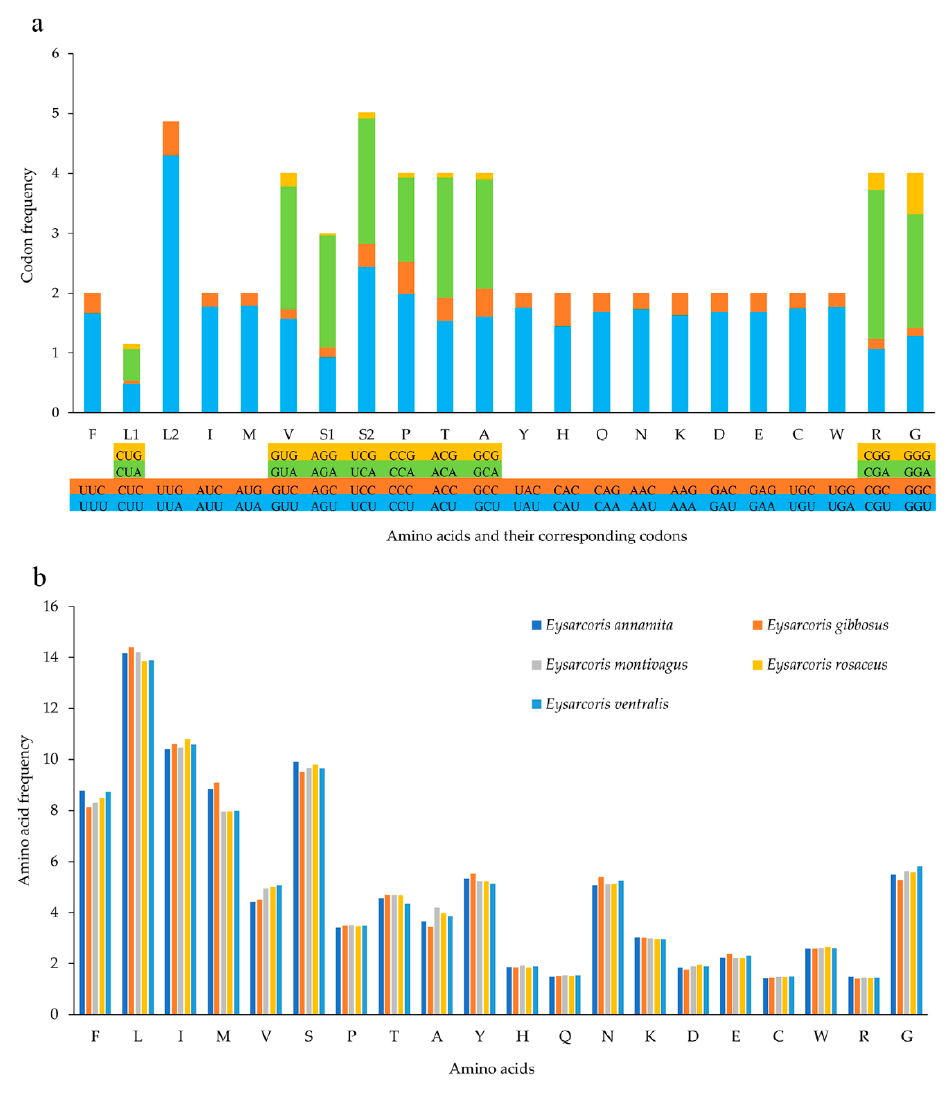
Figure 2. The frequencies of utilized codons by amino acid ( a ) and the frequency of amino acid occurrence ( b ) in the five newly sequenced mitochondrial genomes. The stop codon is not given. The values of Ka, Ks and Ka/Ks were calculated for each PCG to investigate the evolutionary patterns among mitochondrial PCGs in Pentatominae (Figure 3). The Ka/Ks ratio for all 13 PCGs were below 0.73, indicating evolution under purifying selection. The Ka/Ks ratio of nad2 was the highest, while that of cox1 was the lowest. We also observed lower Ka/Ks ratios in the genes that are usually used as a barcode, such as cox2 , cox3 , and cytb .